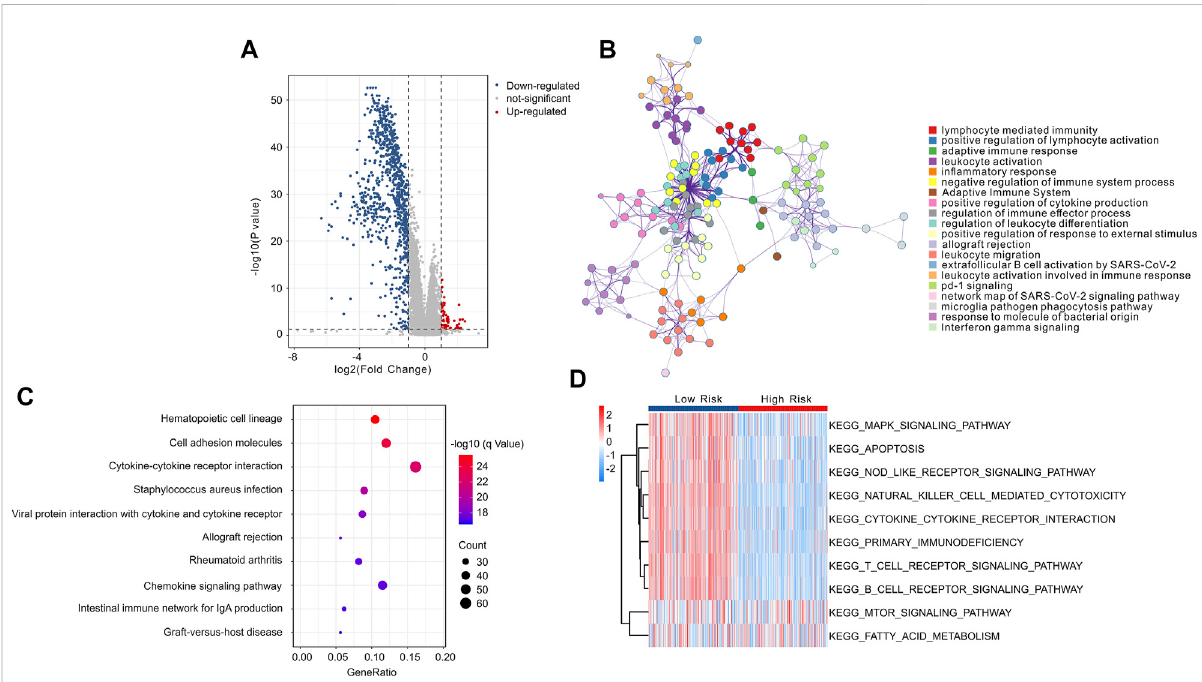
FIGURE 12 Functionalenrichmentanalysisofdifferentialexpressedgenes(DEGs)inlow-andhigh-riskgroup. (A) ThevolcanodiagramexhibitstheDEGsin low-andhigh-riskgroupwiththethresholdsettingat|FC| ≥ 2and p -value < 0.05. (B) GOenrichmentanalysisofDEGsinlow-andhigh-riskgroups. (C) KEGG enrichment analysis of DEGs in low- and high-risk groups. (D) GSVA shows the KEGG terms of each CM patient in low- and high-risk